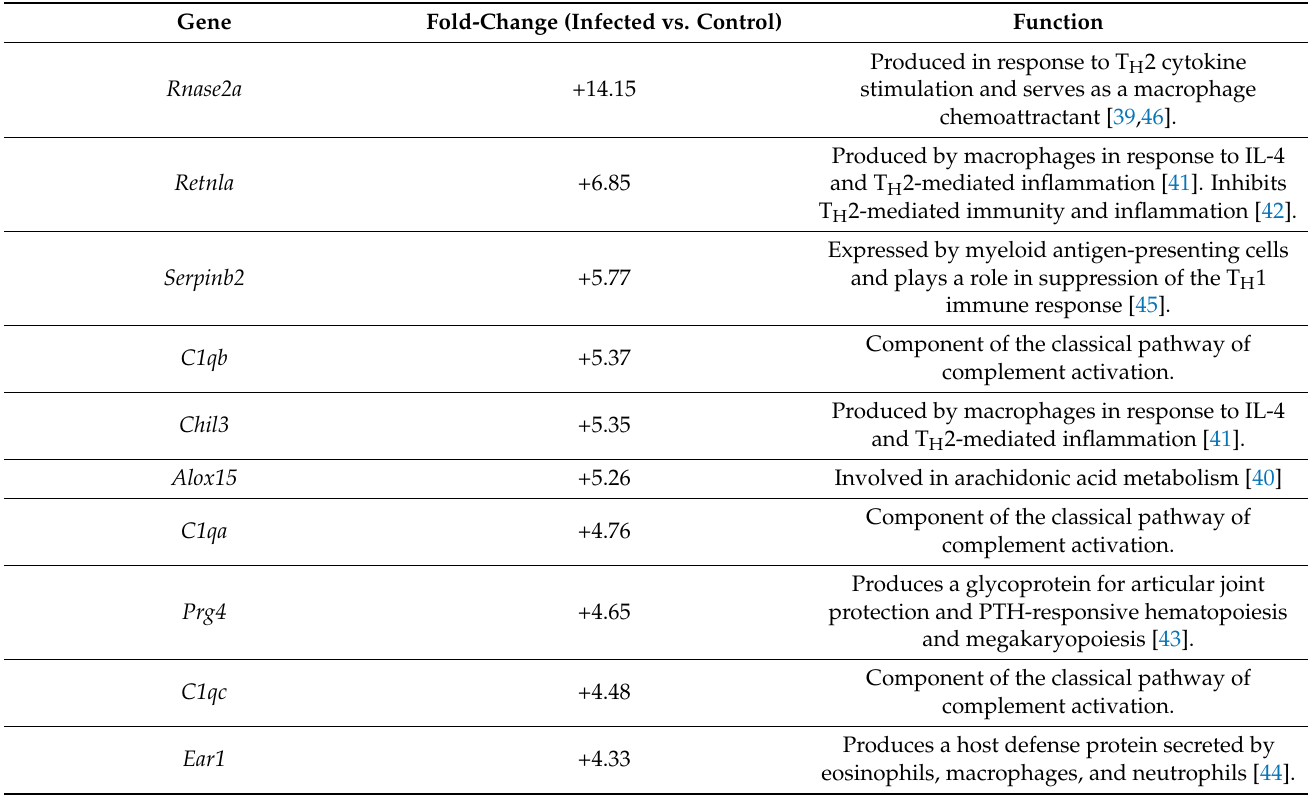
Table 2. Top 10 up-regulated genes in mice infected with Cryptococcus compared to